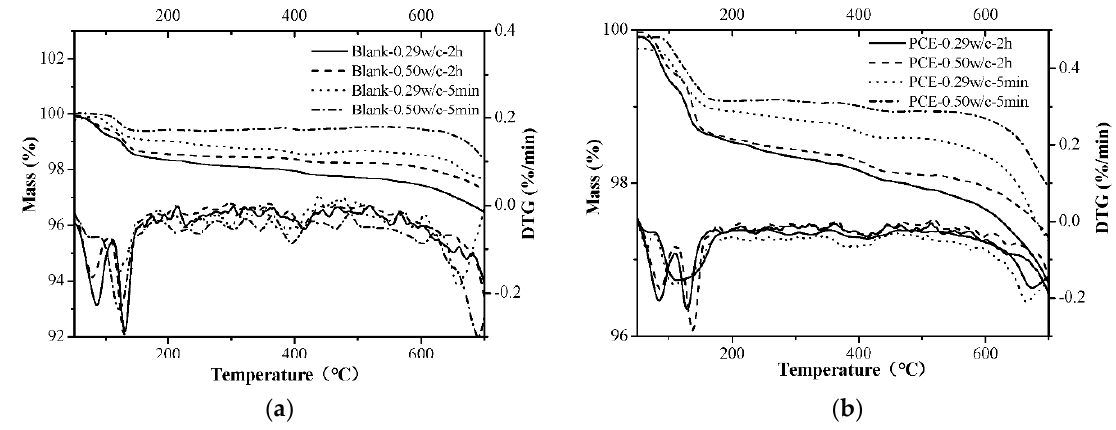
Figure 17. TG analysis of the cement pastes at two w/c ratios without ( a ) and with PCEs ( b ).